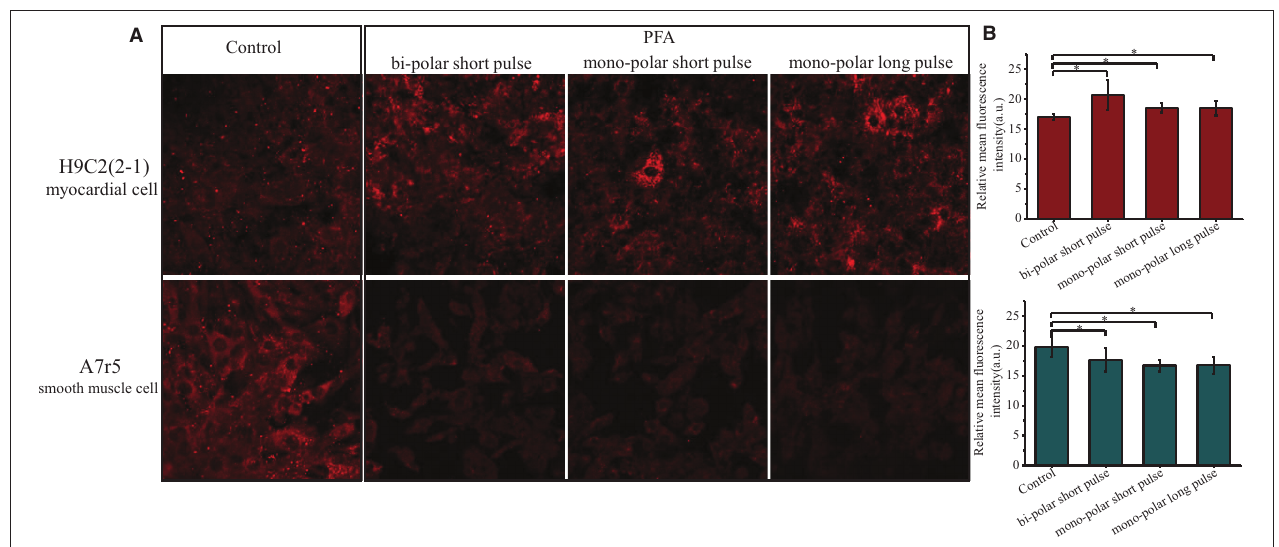
FIGURE 4 | Effect of PFA on Cx45 expression in H9C2(2-1) and A7r5 cells. (A) Cx45 expression in H9C2(1, 2) and A7r5 cells 24h after PFA under three modes. (B) Histogram of mean fluorescence intensity of Cx45 expression in H9C2(2-1) (top) and A7r5 (bottom) cells. * p < 0.05. PFA, pulsed-field ablation.